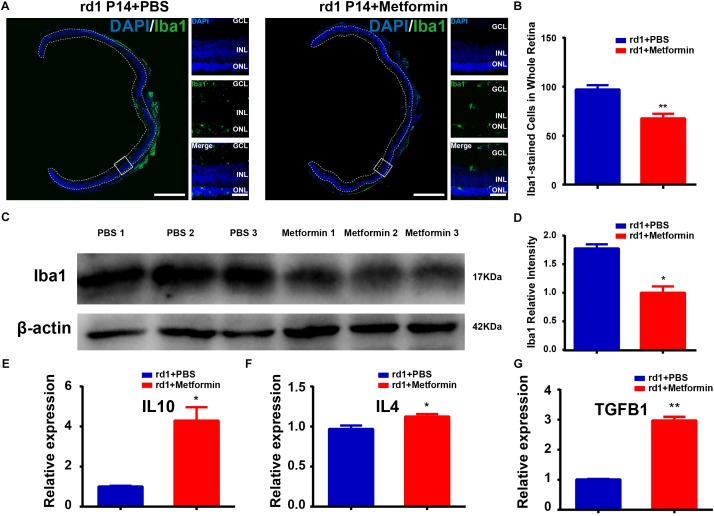
Metformin inhibits the activation of microglia and inflammation in rd1 mice at P14. (A) Whole retinal montage and partial enlargement of an image showing Iba1 staining in the control and Met groups. (B) Comparison of the number of Iba1-positive cells in the whole retina. n = 5 mice per group. (C) Representative Western blot bands of Iba1 versus β-actin. (D) Comparison of protein grayscale semiquantitative analysis between the control group and the Met group. n = 3 mice per group. (E–G) Real-time PCR analysis of the expression of IL10, IL4, and TGFB1. n = 3 mice per group. ∗P < 0.05, ∗∗P < 0.01. Scale bar: whole retinal map, 500 μm; enlarged view, 50 μm.